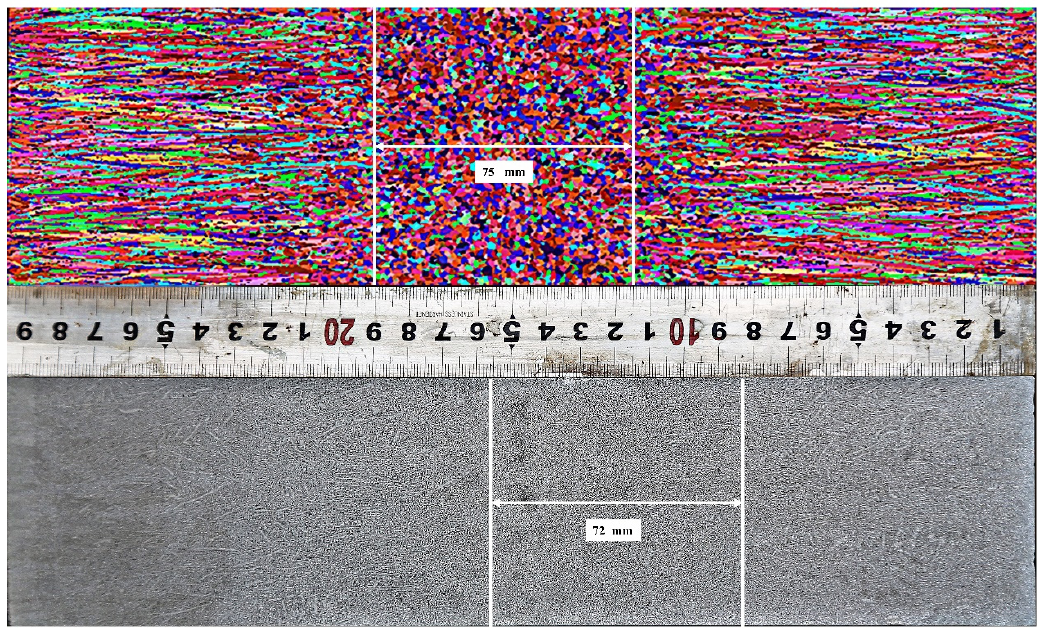
Figure 6. Comparison of numerical and experimental structures of S-1 steel.